Question: What form of chart is displayed?
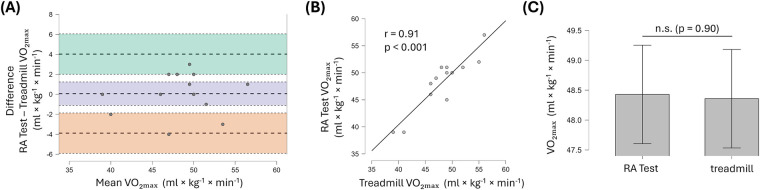
Answer: scatter